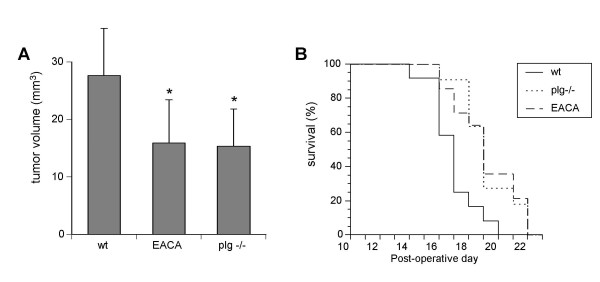
Effect of plasminogen in tumor metastasis. Metastatic brain tumors were established by injecting 106 B16F10 cells in the left internal carotid artery of wild type wild type C57Bl (wt), plasminogen deficient (plg-/-) and wild type mice treated with EACA (EACA). Fourteen days after tumor cell injection the mice were sacrificed the brains removed fixed and stained with hematoxylin eosin. The areas of the tumors at 200 μm intervals were measured and the total volume of the tumor determined. Note the reduced tumor size in mice treated with EACA and plg-/- mice compared to wild type mice. B) Survival graph of 12 wild type mice (wt), 11 plg-/- mice (plg-/-) and 7 wild type mice treated with EACA (EACA) injected with 106 B16F10 cells. Note the increased survival of plg-/- and wild type mice treated with EACA compared to untreated wild type mice (p < 0.03)